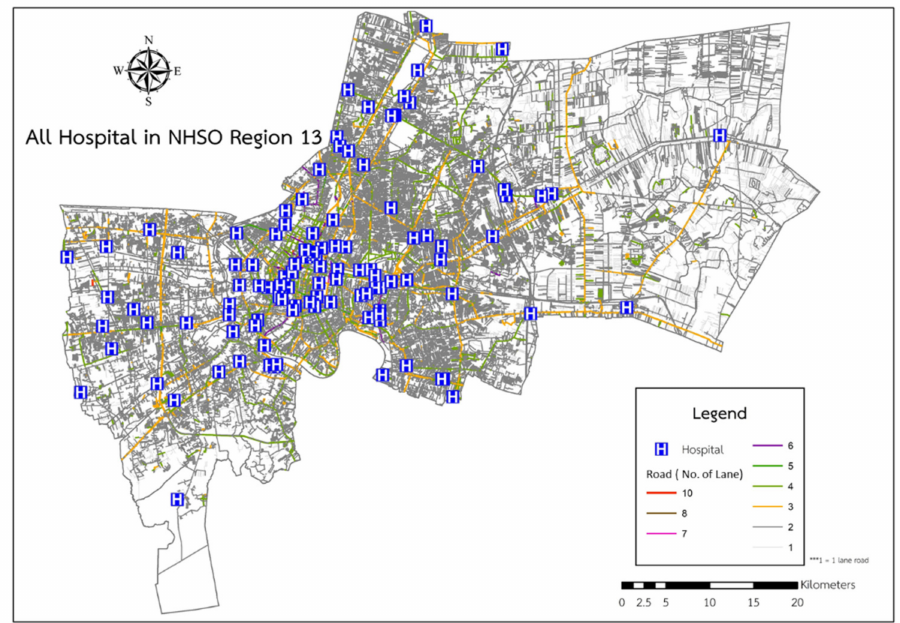
Figure 1. Hospitals in the Stroke Service Plan of NHSO Region